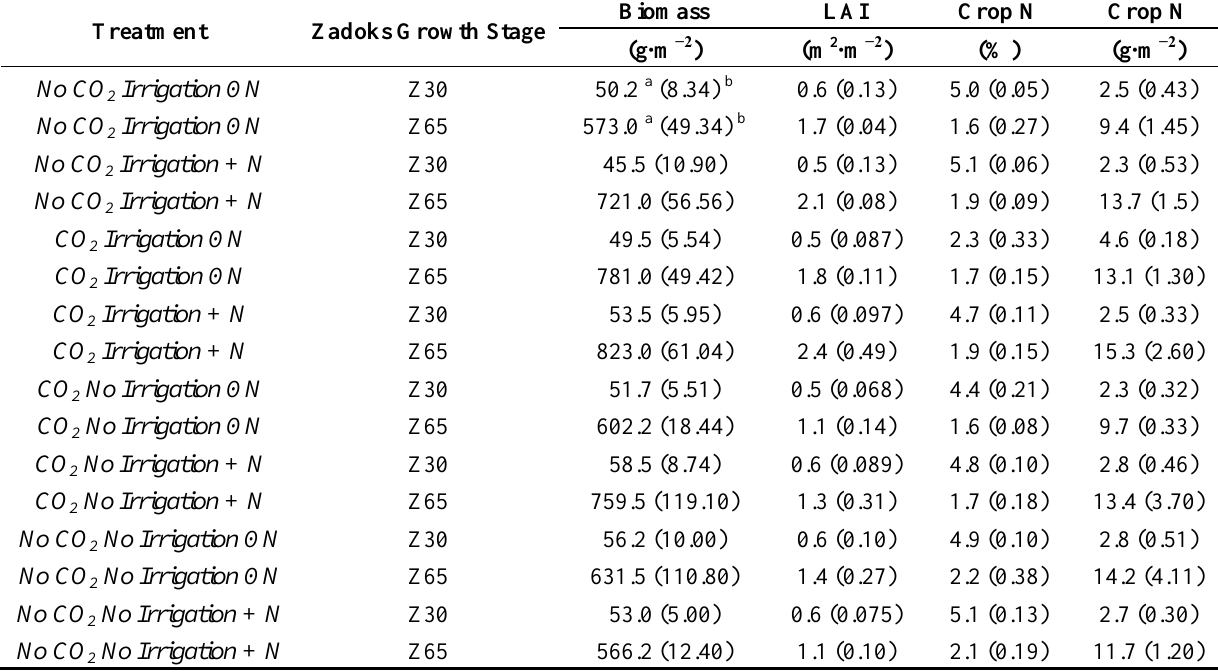
Table 3. Mean wheat biophysical variables from Horsham (Australia) for the 2007 growing season at stages Z30 and Z65 for the cultivar